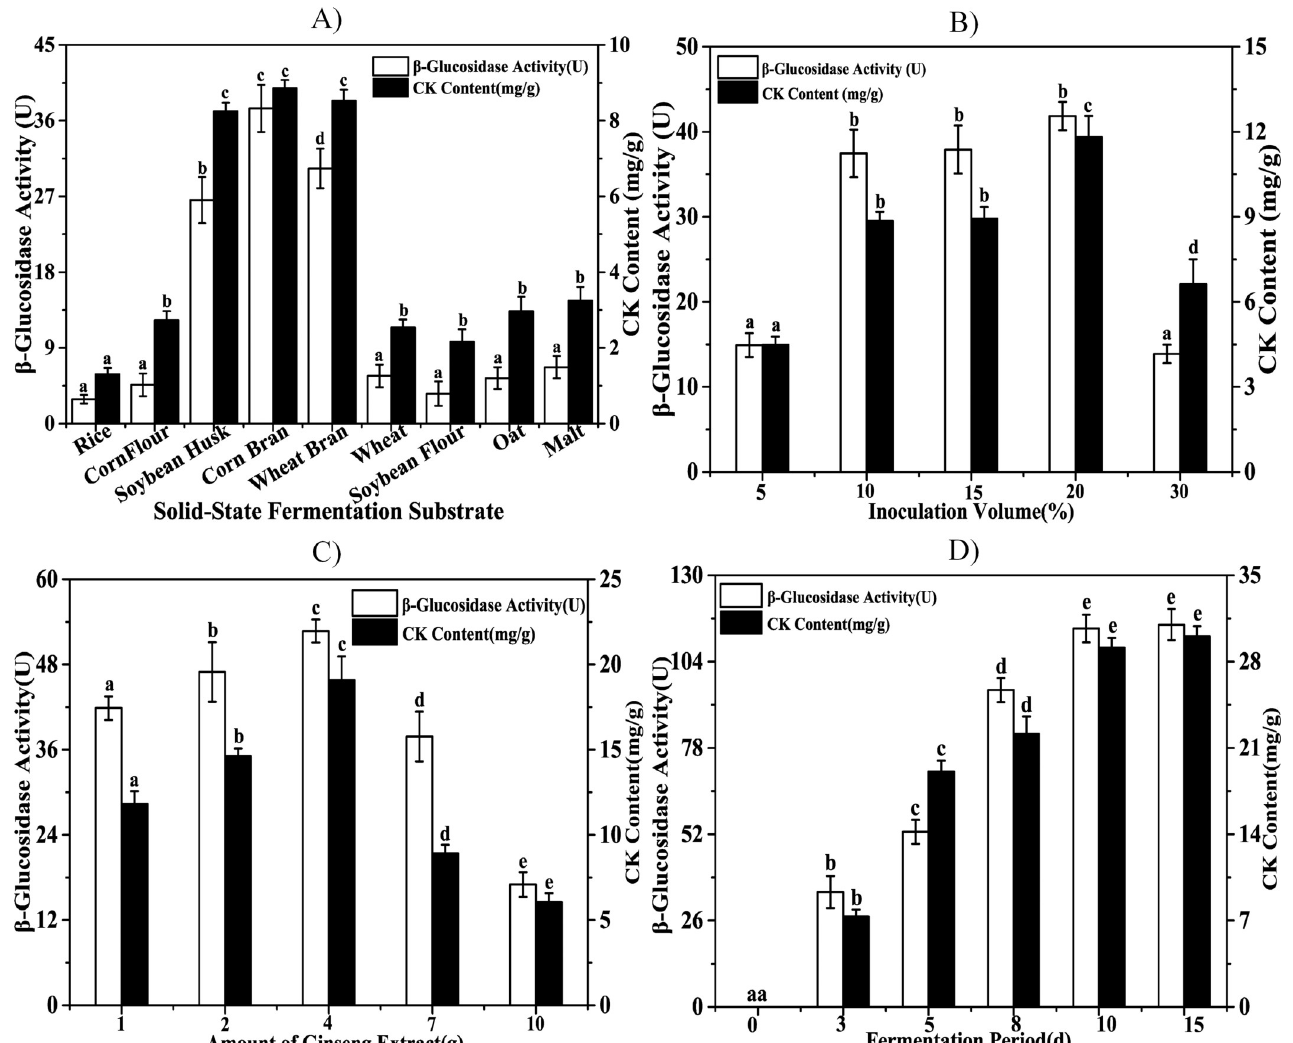
Fig 5. Optimization of main SSF process parameters for maximum CK content and β -glucosidase activity. A: Effect of the solid-state fermentation substrate (20 g); B: Effect of inoculation volume (%); C: Effect of the amount of ginseng extracts (g); D: Effect of fermentation period (d). Values are shown as means ± SD of three replications. A one-way ANOVA was used to assess the statistical significance of the differences in expression levels. Different letters (a-e) indicate significant differences between each other (P <